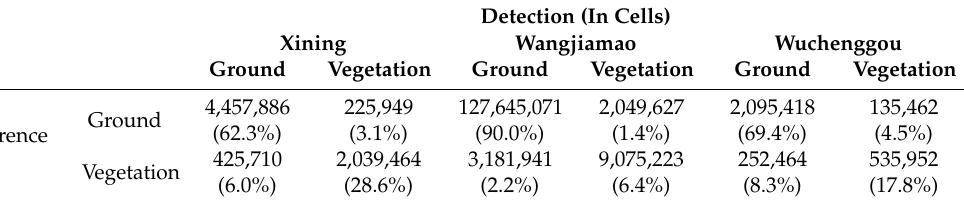
Table 4. Confusion matrix of vegetation detection results in three areas for architecture C.